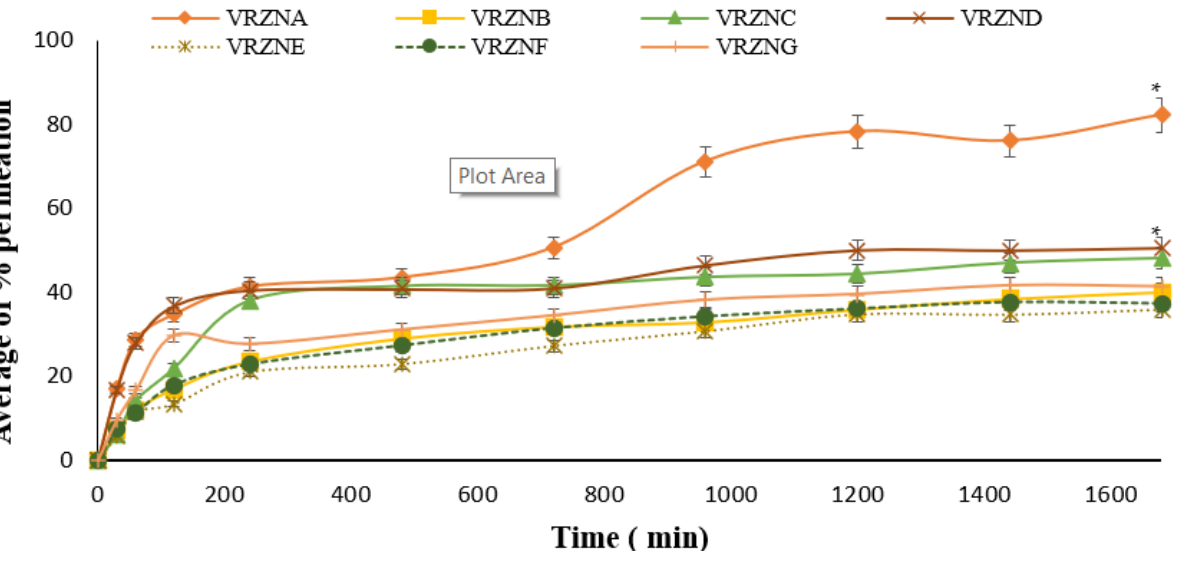
Figure 4. In vitro average of % permeation of formulations: n = 3, mean ± S.D., * p < 0.05 considered statistically significantly different from VRZNB, VRZNC, VRZNE, VRZNF, and VRZNG.